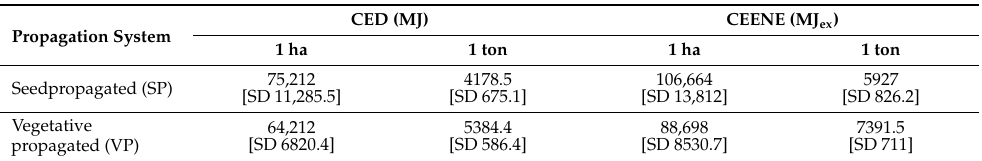
Table 4. Cradle-to-farm gate cumulative energy demand (CED) and cumulative exergy extraction from the natural environment (CEENE) for seed and vegetative propagated globe artichoke. SD denote standard deviation.